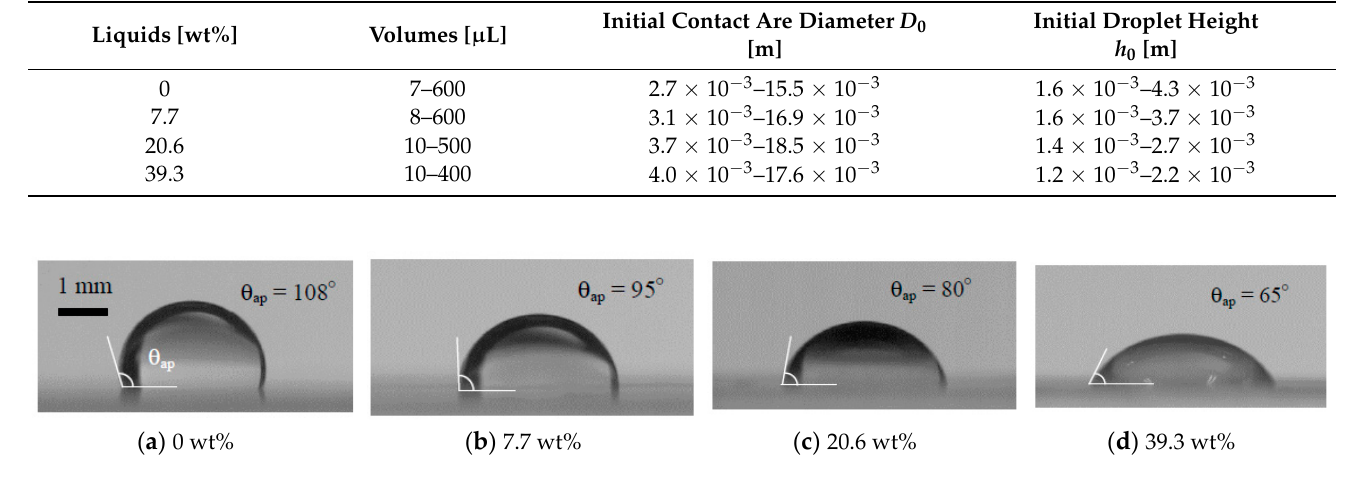
Figure 2. Droplet wettability of each liquid on silicone rubber (SR): ( a ) 0 wt% (0.072 Nm − 1 ), ( b ) 7.7 wt% (0.051 Nm − 1 ), ( c ) 20.6 wt% (0.038 Nm − 1 ) and ( d ) 39.3 wt% (0.030 Nm − 1 ). Droplet volume V 0 is 10 μ L.